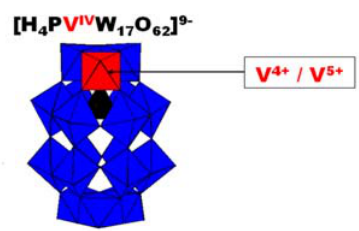
[H V IV PW O ] (abbreviated as HPV IV ) 9 4 17 62